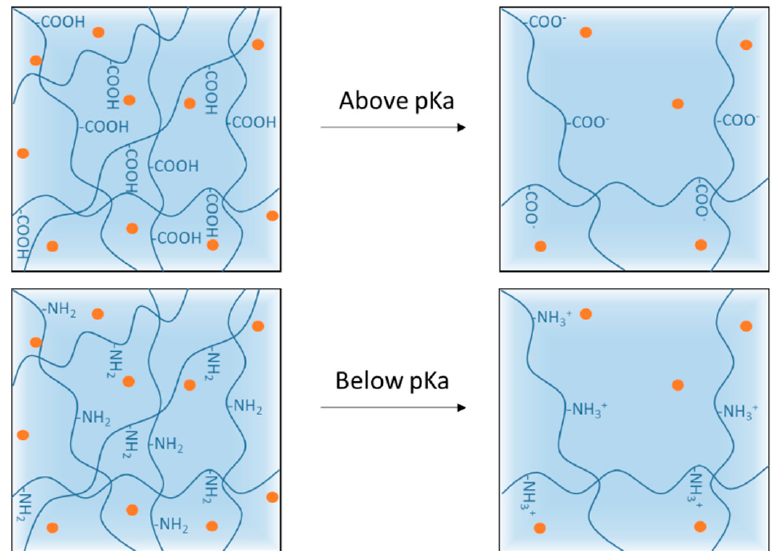
Figure 3. Schematic illustration of pH-responsive hydrogel response to surrounding medium pH variations (above: anionic polymer, below: cationic polymer).